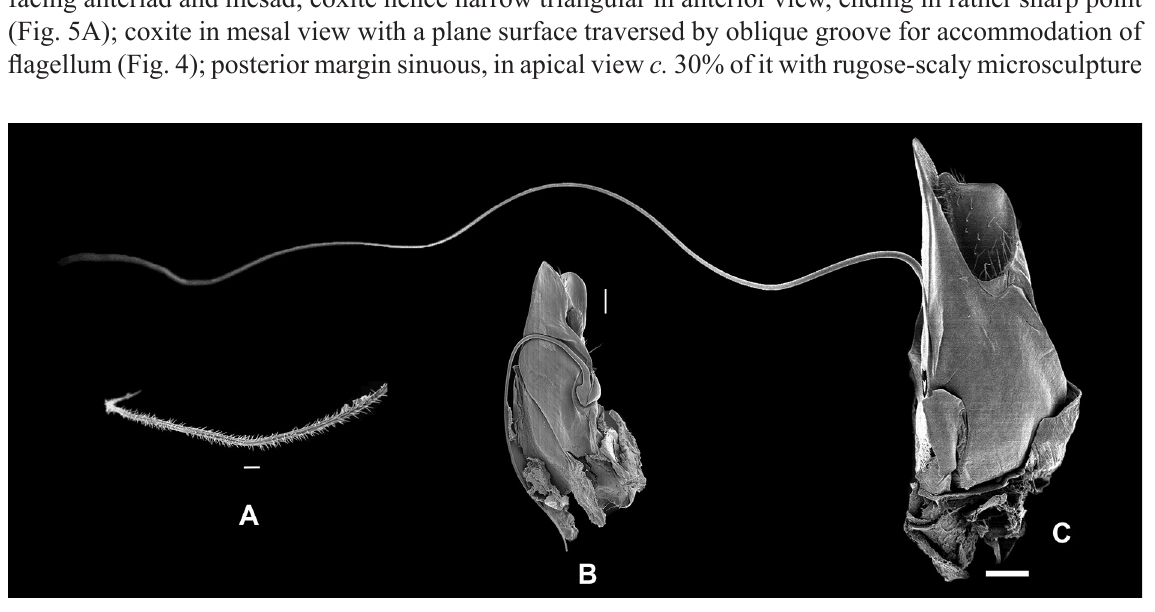
Fig. 4. Chiraziulus kaiseri (Mauriès, 1983), ♂, paratype, anterior gonopod. Scanning electron micrographs. A . Tip of flagellum. B . Flagellum insertion and loop across anterior gonopod coxite. C . Anterior gonopod showing the entire extension of the flagellum. Scale bars: A = 10 μm; B–C = 100